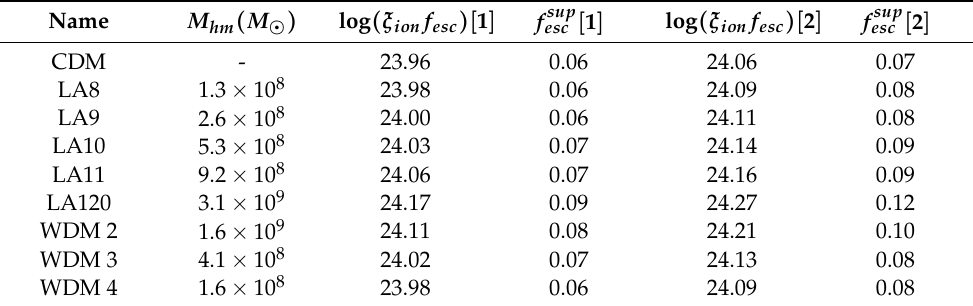
Table 3. Product log ( ξ ion f esc / ( erg − 1 Hz )) and upper limit of f esc , with ξ ion = 10 25.2 Hz / erg , for different cosmologies and different initial conditions. We note that these two quantities increase with the half-mode mass ( M hm ) . The case [1] refers to Q HII ( z = 10 ) = 0.2. The case [2] refers to Q HII ( z = 9 ) =